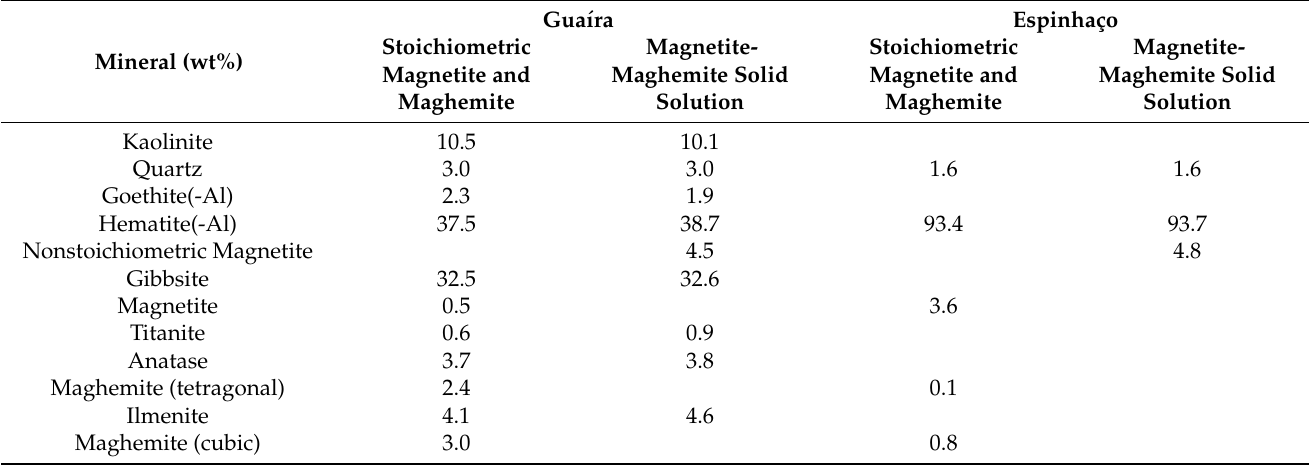
Table 5. Rietveld method quantitative phase analysis, comparing the magnetite–maghemite solid solution approach with the refinement using stoichiometric magnetite, cubic maghemite and tetragonal maghemite structures, for a soil (Gua í ra) and a Quadril á tero Ferr í fero iron ore (Espinhaço)